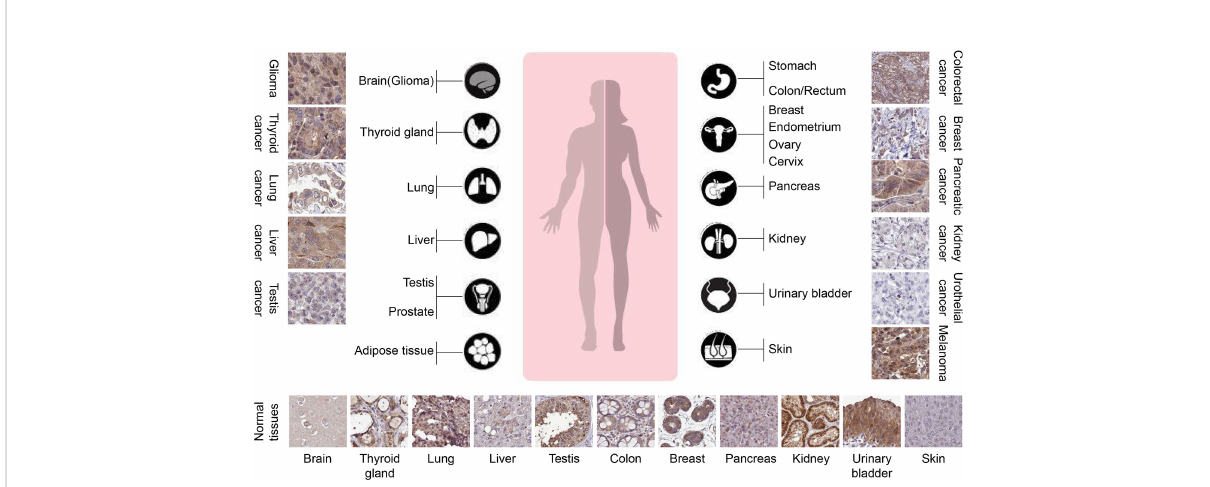
FIGURE 2 TRIM31 is highly expressed in several types of tumors (The Human Protein Atlas data). The rabbit polyclonal antibody HPA046400 (Sigma Aldrich) was used for the immunohistochemistry assay. The cancer tissues of glioma, melanoma, thyroid gland, pancreatic cancer and liver cancer were strongly cytoplasmic stained. Occasional membranous positivity was observed in colorectal cancer. Urothelial cancer and most kidney cancers were negatively stained. Normal tissues showed weak to strong cytoplasmic positivity with HPA046400 antibody, as presented at the bottom. In glioma, thyroid cancer, liver cancer, colorectal cancer, and pancreatic cancer, the expression of TRIM31 in cancer cell cytoplasm is higher than that in adjacent normal tissues. However, in lung cancer, testis cancer, kidney cancer, and urothelial cancer, the expression of TRIM31 was lower than that in adjacent normal